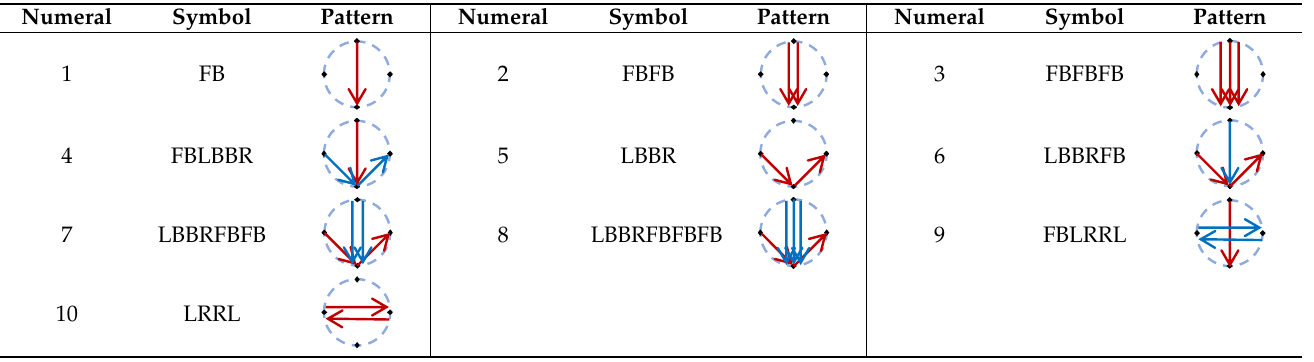
Table 1. The digital instruction table for the choker. Red arrows in the pattern columns indicate the first group of strokes, while blue arrows indicate the second.